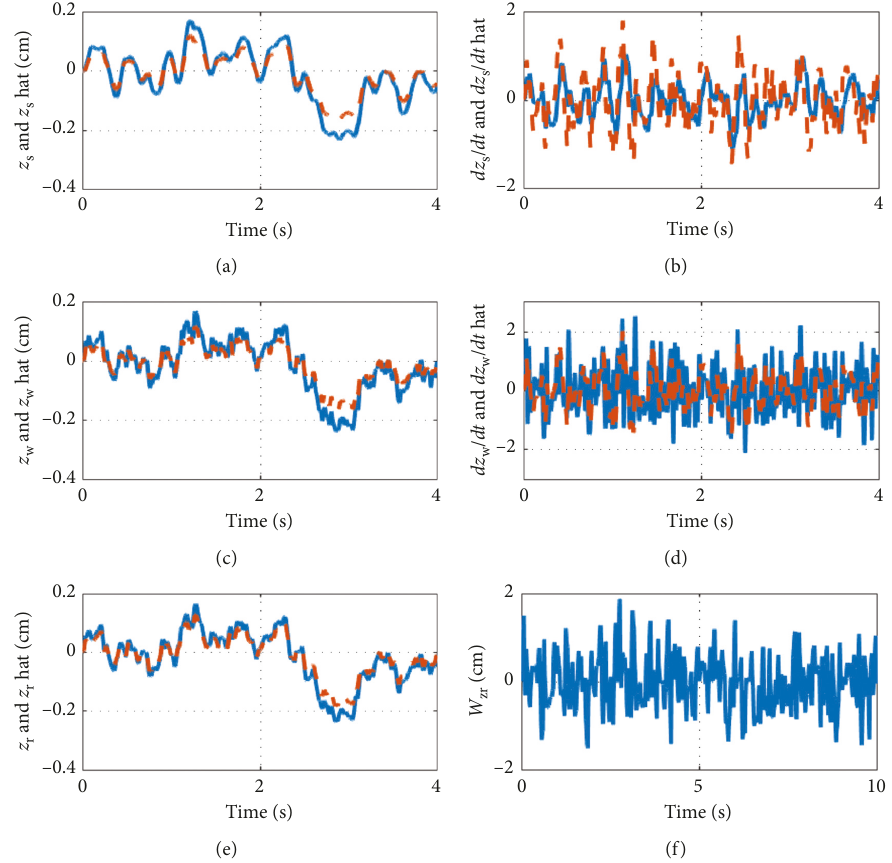
Figure 13: The real states (solid line) and estimated states using SPKF (dotted line) in the case of 20km/h. (a) z dt hat. (c) z w and z w hat. (d) dz w / dt and dz w / dt hat. (e) z r and z r hat. (f) w